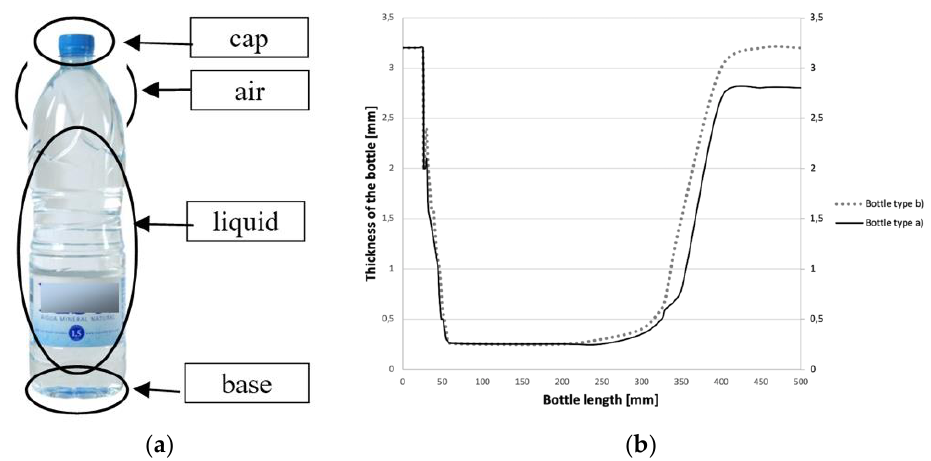
Figure 3. Modeling the bottle: ( a ) main elements; ( b ) example of characteristic thickness [33].